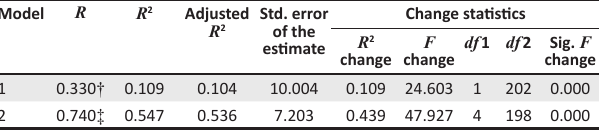
TABLE 6: Regression analysis model summary output: Behaviour modification practices and English language reading abilities. Model